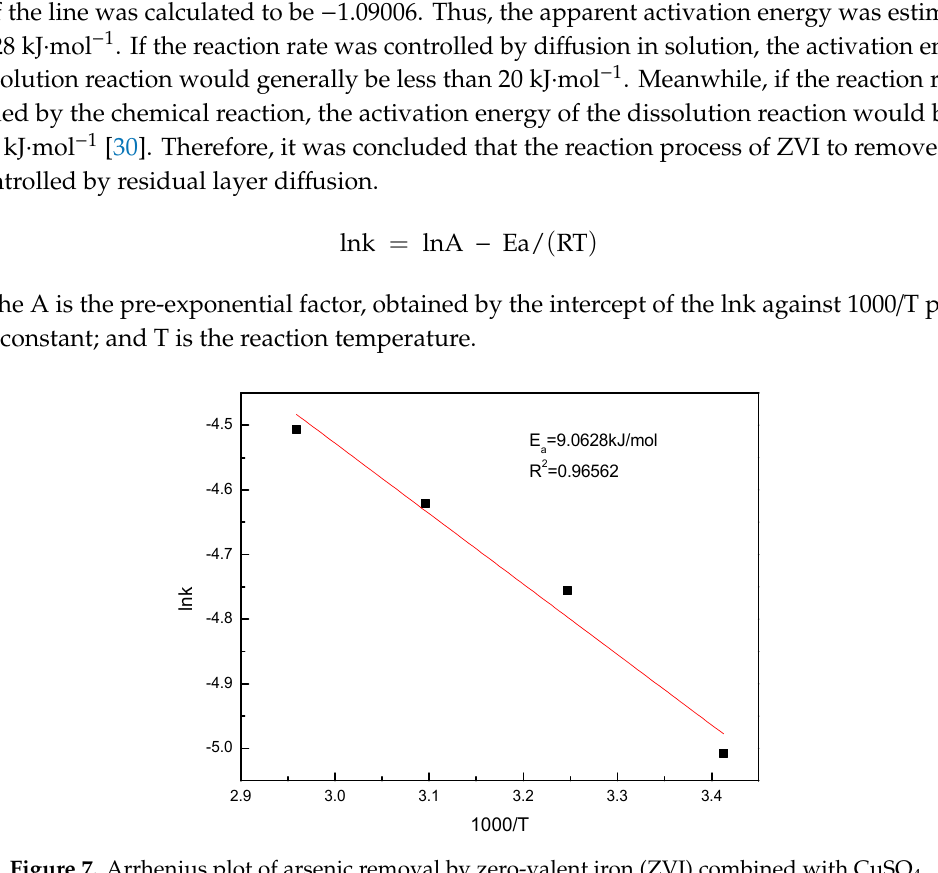
Figure 7. Arrhenius plot of arsenic removal by zero-valent iron (ZVI) combined with CuSO 4.